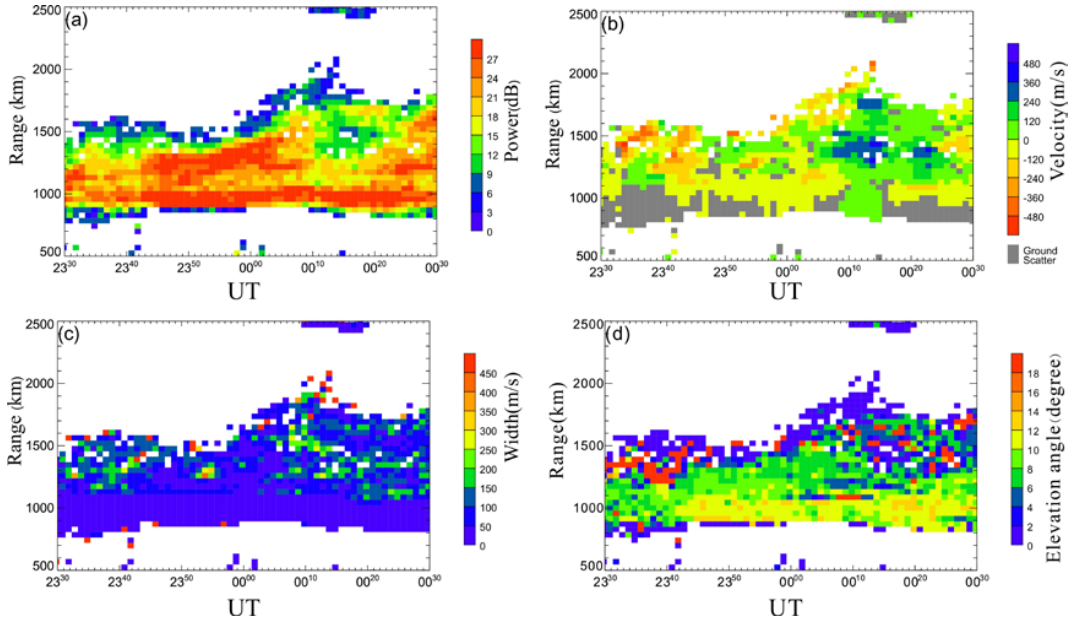
Fig. 1. Hankasalmi radar beam 9 echo maps for (a) power, (b) Doppler velocity, (c) width and (d) elevation angles from 23:30UT on 15 May to 00:30UT on 16 May 2008. The radar operating frequency was